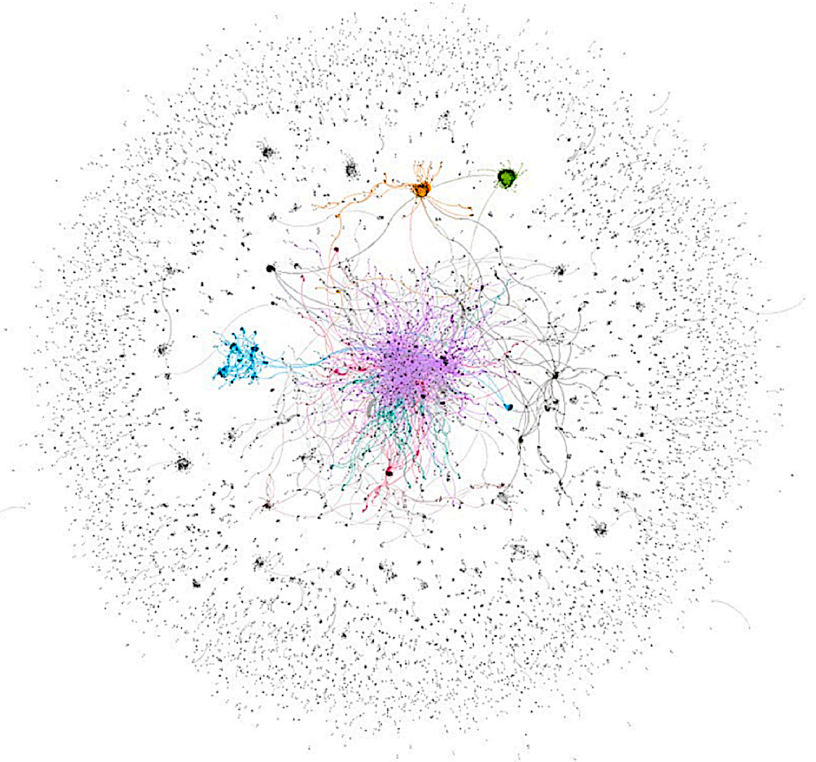
Figure 1. Sociogram of the overall network structure. Legend: n = 10,694. Each dot (node) represents a unique user, and the lines (edges) between the nodes reflect exchanged tweets (mentions and retweets). Color clusters indicate sets of users, called communities, who were algorithmically determined based on how frequently users interact together [24]. Within one community, individuals communicate with each other more frequently than with individuals outside their community. Table 1. Breakdown of influencer types.